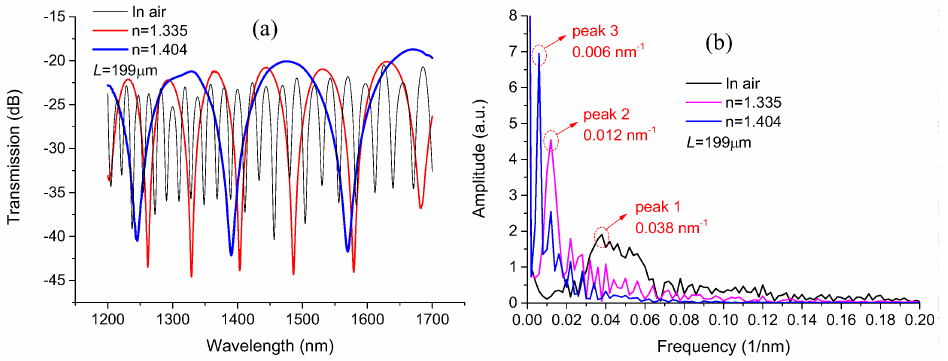
Figure 5. ( a ) Transmission spectra and ( b ) spatial frequency spectra of the MCMZI in air and different RI liquid environments, for the device with cavity length 199 µ